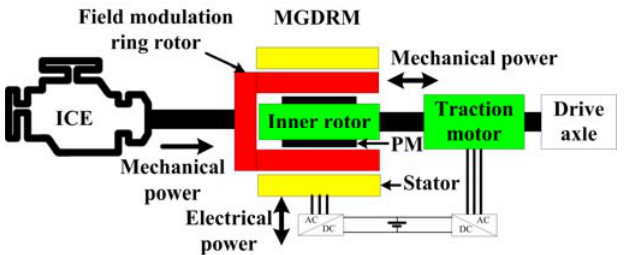
Figure 26. Dual-rotor magnetic-geared brushless ECVT.